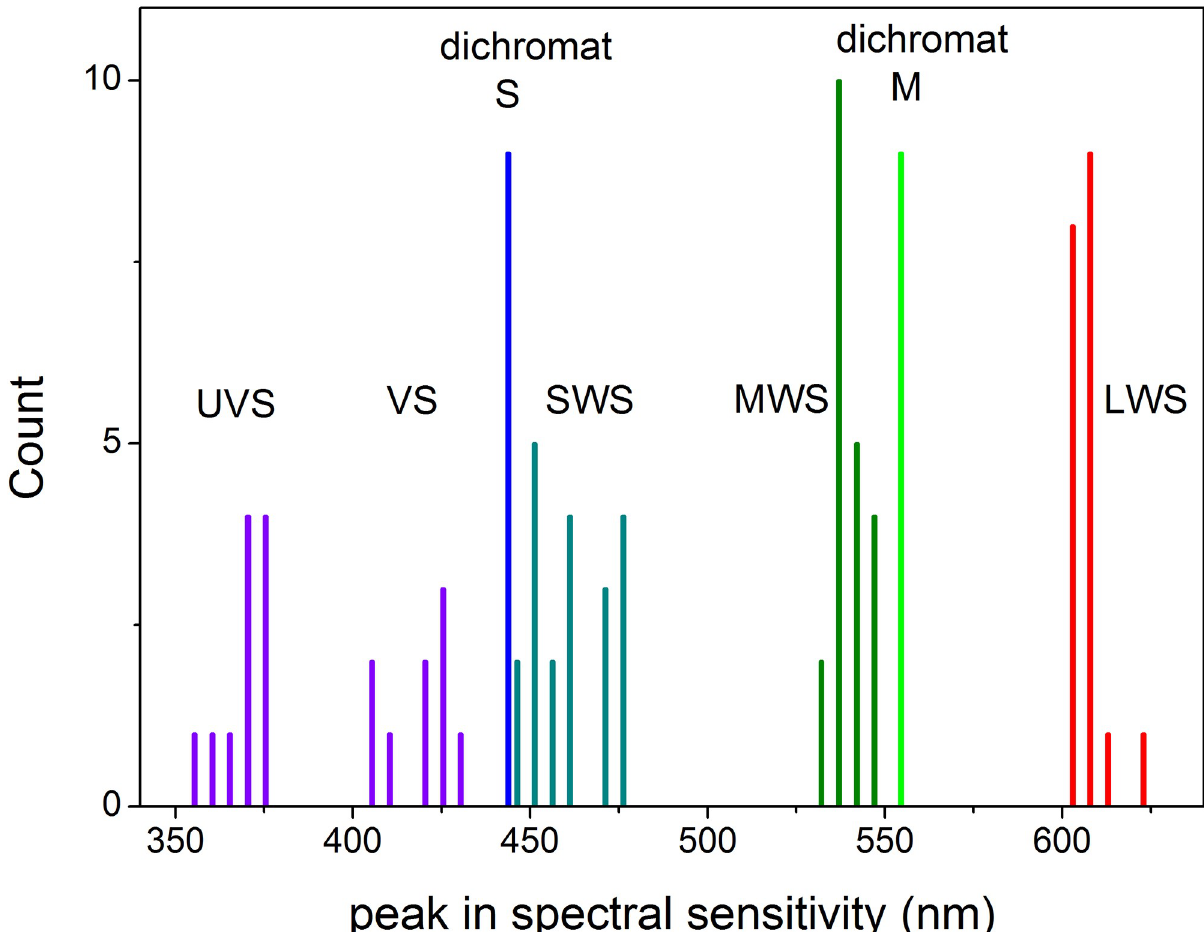
Fig 5. Comparison of peak spectral responses of predator and bird cones. Peak single cone spectral sensitivities for ferret S and L cones (Douglas & Jeffery, 2014) and for bird VS/UVS, SWS,MWS and LWS cones from Fig 5B in (Hart & Hunt, 2007) for 21 species of birds from 9 orders.